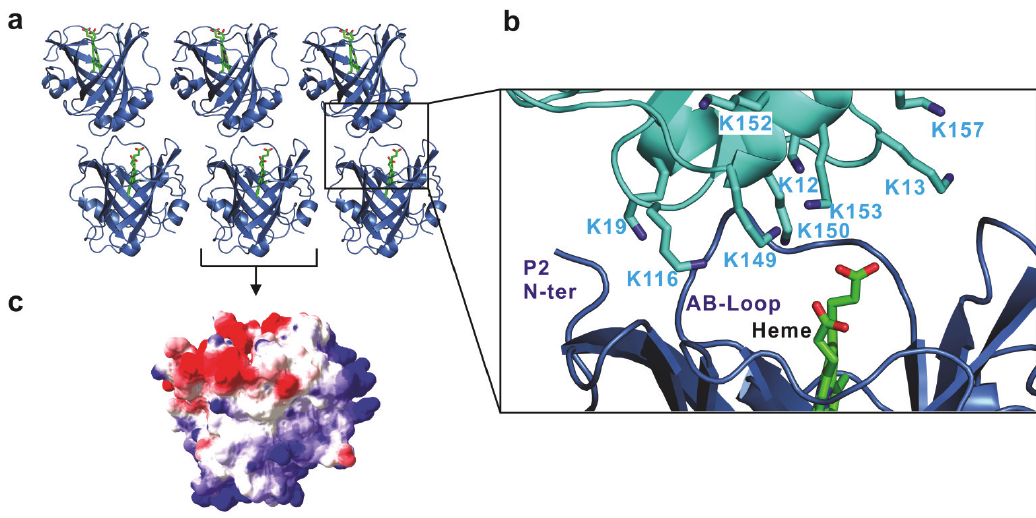
Figure 2. Head-to-tail arrangement of NP7 in the crystal lattice. ( a ) Arrangement of molecules in the crystal lattice of NP7. ( b ) Crystal contact between two neighboring molecules in the NP7 crystal. ( c ) The electrostatic potential of NP7. The red and blue colors show the negative and positive potentials, respectively.